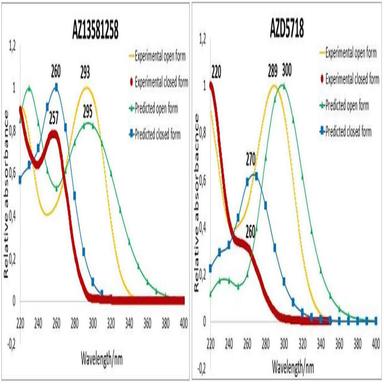
UV-spectra of the main compound and the peaks present in acidic chromatographic setup assumed to be tautomers, AZ13581258 and AZD5718 respectively, see 2. Data obtained by the PDA detector and compared with predicted UV spectra using TD-DFT.